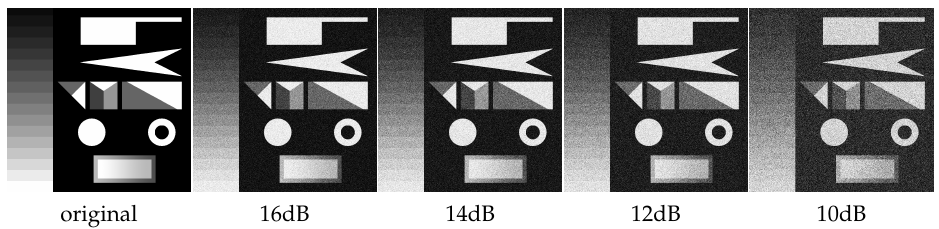
Figure 11. Image used to evaluate at different levels of noise (PSNR).